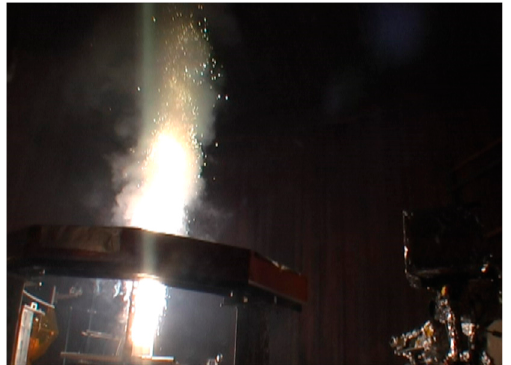
Figure 16. This is an image from a burning 5 ″ (12.7 cm) diameter charge of aluminized composite propellant.